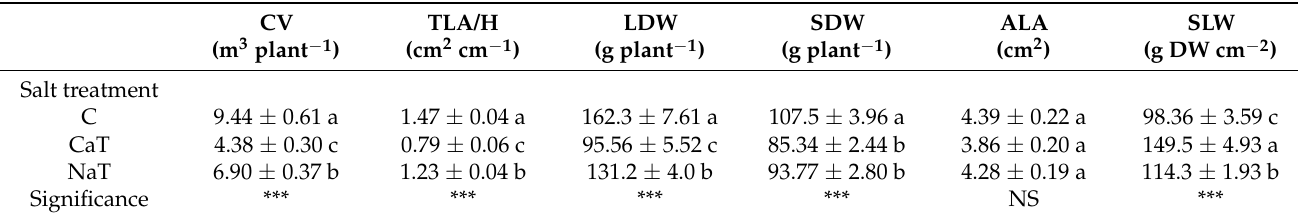
Table 1. Effects of salt treatment in the nutrient solution on canopy volume (CV), total leaf area (TLA) per plant height (H), leaf dry weight (LDW) and stem dry weight (SDW) per plant, average leaf area (ALA), and specific leaf weight (SLW) in C. citrinus plants. Mean values and standard errors are shown. Different letters correspond to significantly different values ( p <